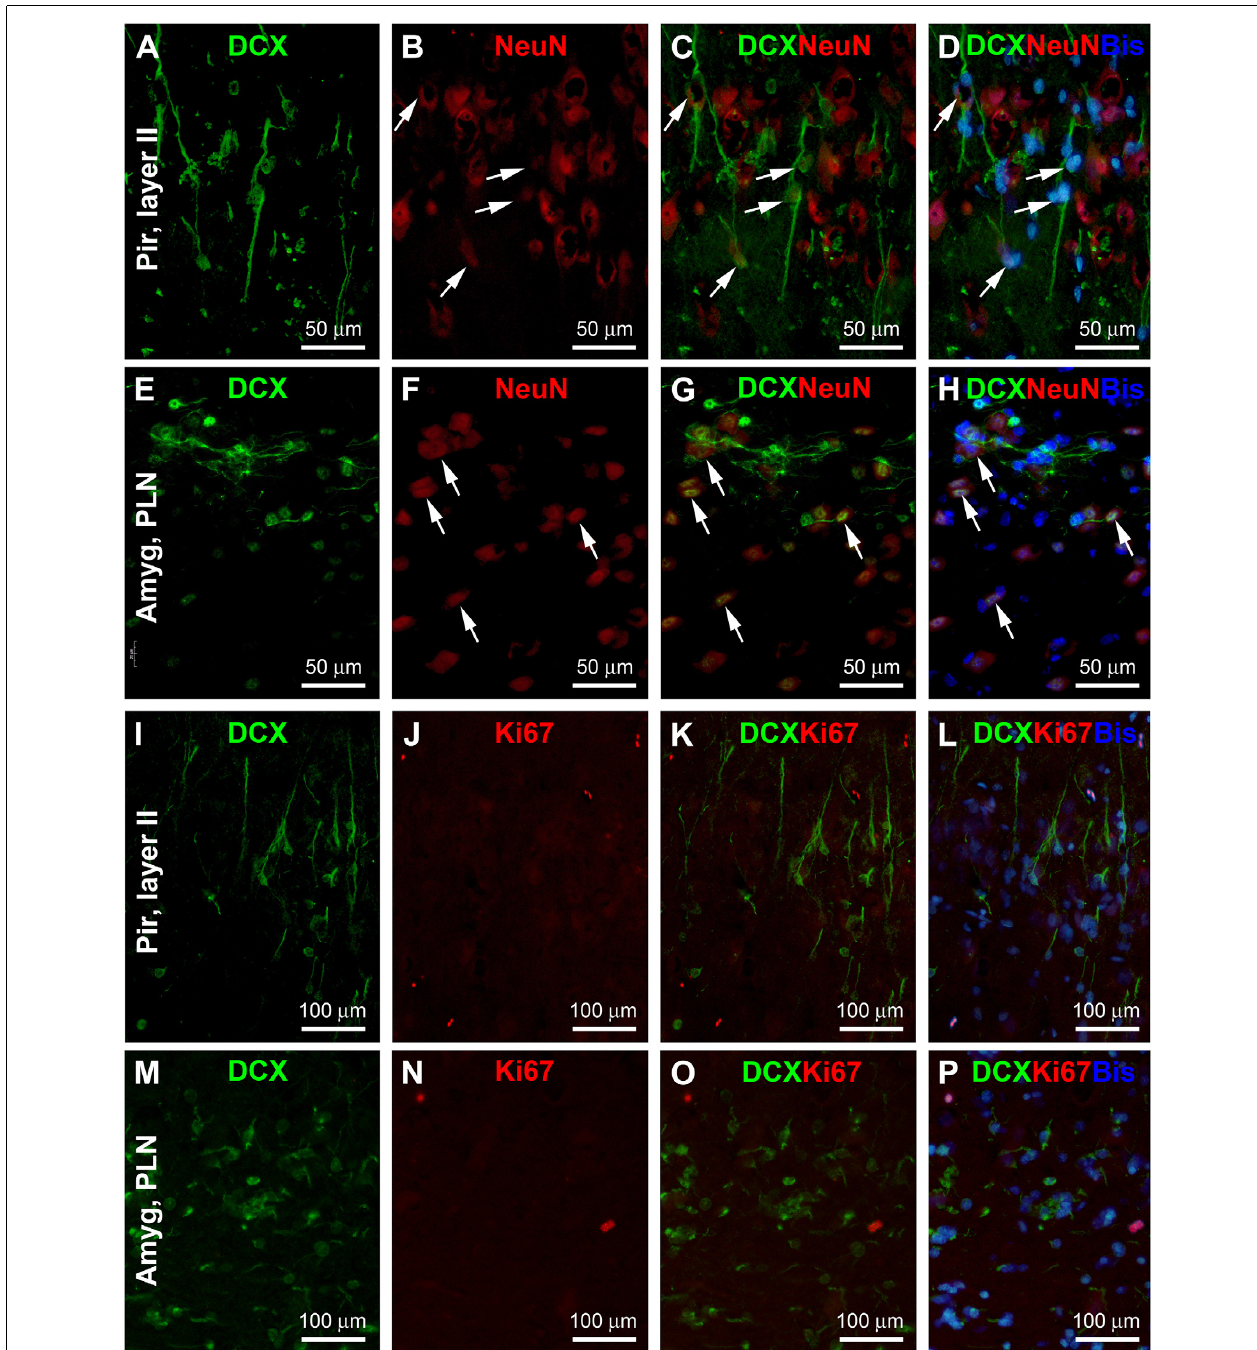
FIGURE 7 | Double immunofluorescent characterization of DCX colocalization with the neuron-specific nuclear antigen (NeuN) and Ki67 in layer II of the piriform cortex (Pir) and paralaminar nucleus (PLN) of the amygdala (Amyg), with bisbenzimide (Bis) used to mark the cell nuclei (assessed in 2 years-old adult tree shrews). In both areas, there exists a partial colocalization of NeuN among the DCX+ cells ( A–H , examples are pointed by arrows), whereas no Ki67 labeling is seen in the DCX+ cells (I–P) . Image locations, fluorescent channels, and scale bars are as indicated in the panels.